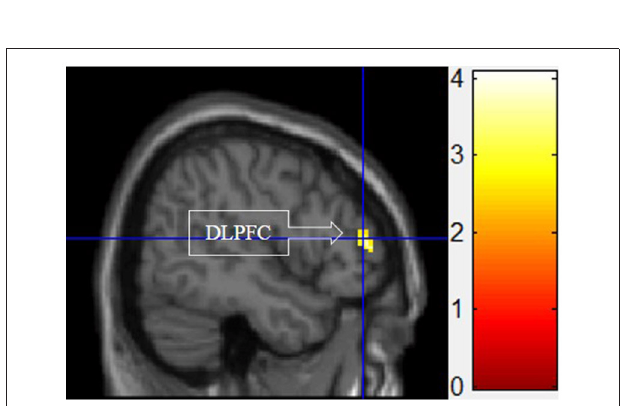
FIGURE 5 | Functional motivation > symbolic and experiential motivations. The color bar reflects t -values that resulted from the contrast. The DLPFC showed significantly higher activation while processing products with functional motivation as compared to both symbolic and experiential